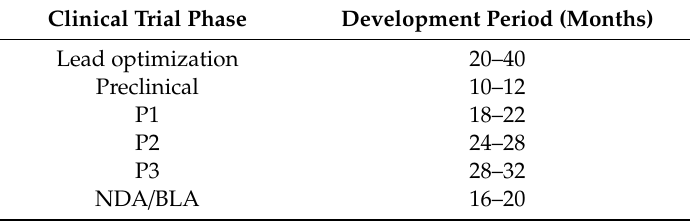
Table 3. Bogdan’s phased development period.